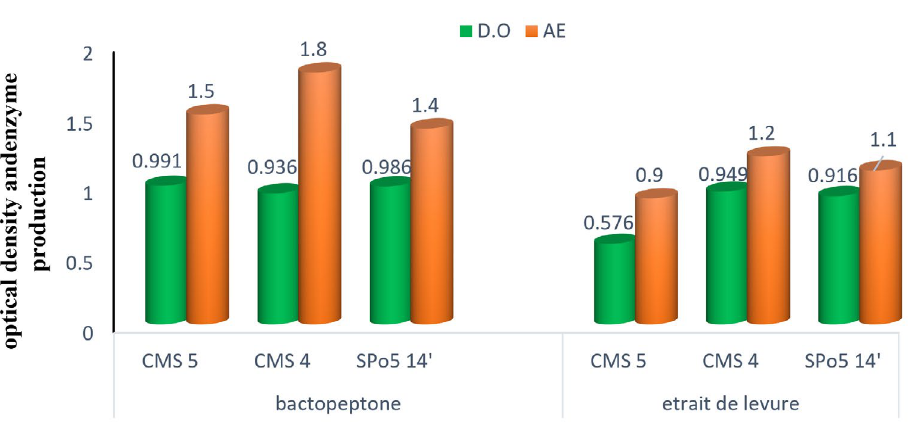
Fig. 9. The effect of nitrogen sources on the growth and enzymatic production of three Bacillus strains: Bacillus subtilis (CMS5), Bacillus sp. (CMS4) and Bacillus velenzensis (SPo5